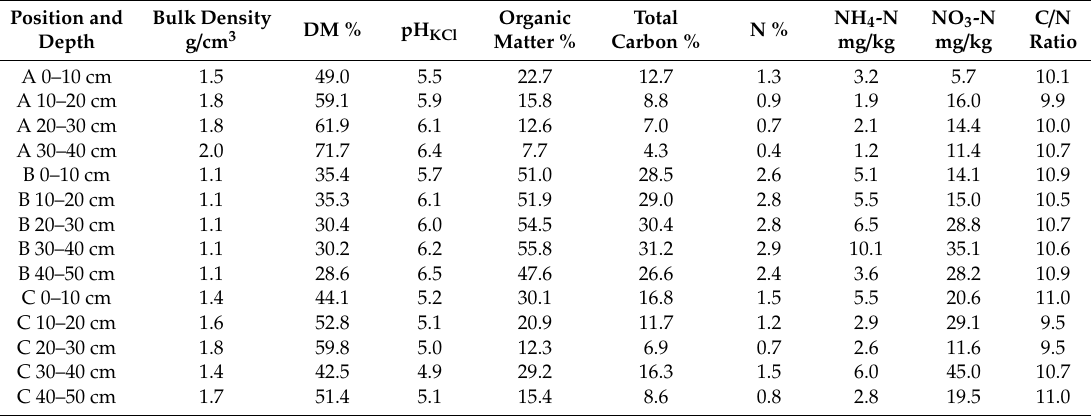
Table 1. Soil properties at Kärevere field site. DM—dry matter.